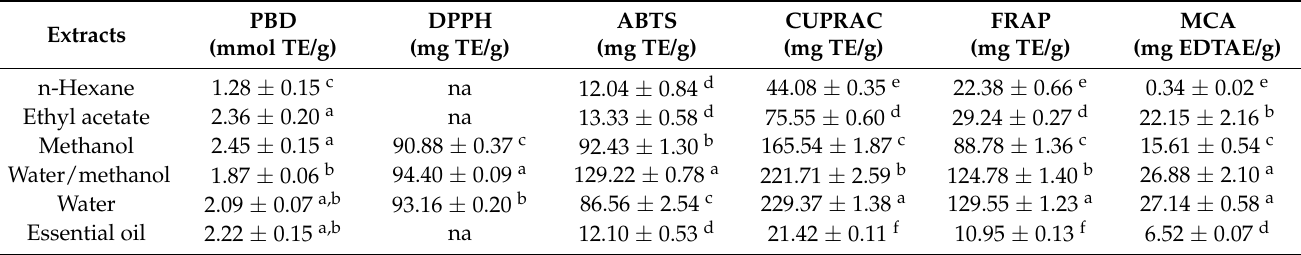
Table 5. Antioxidant properties of the tested